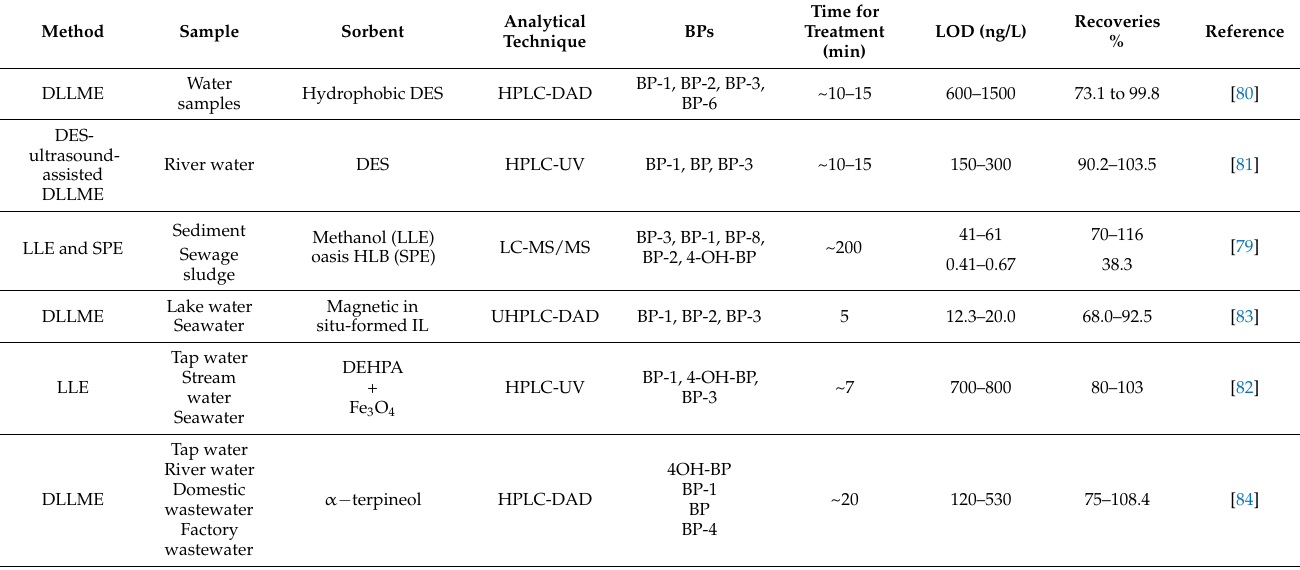
Table 4. Sample preparation methods based on LLE procedures for BP